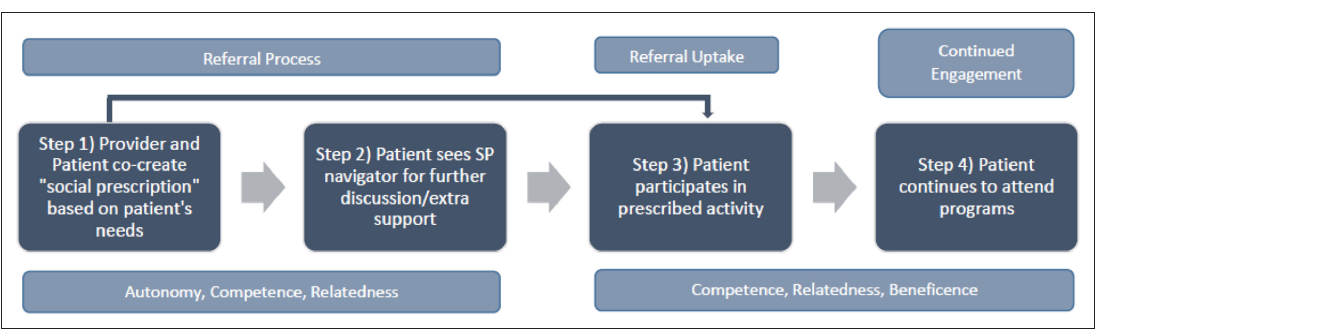
Figure 1 Theoretical framework of self- determination theory applied to the social prescribing